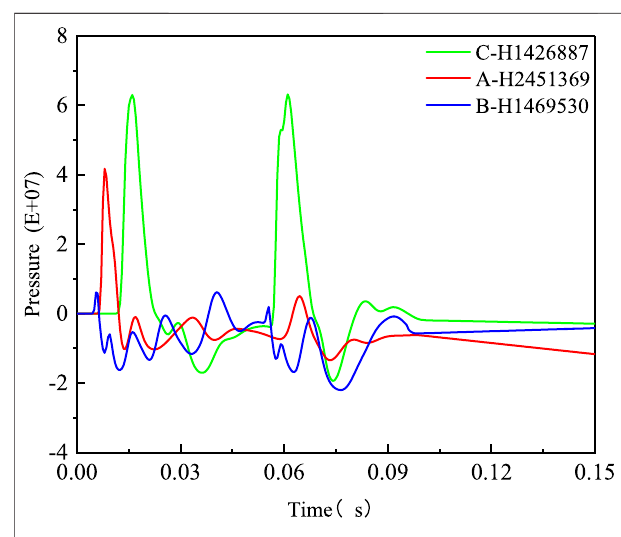
FIGURE 8 | Stress diagram of the monitoring